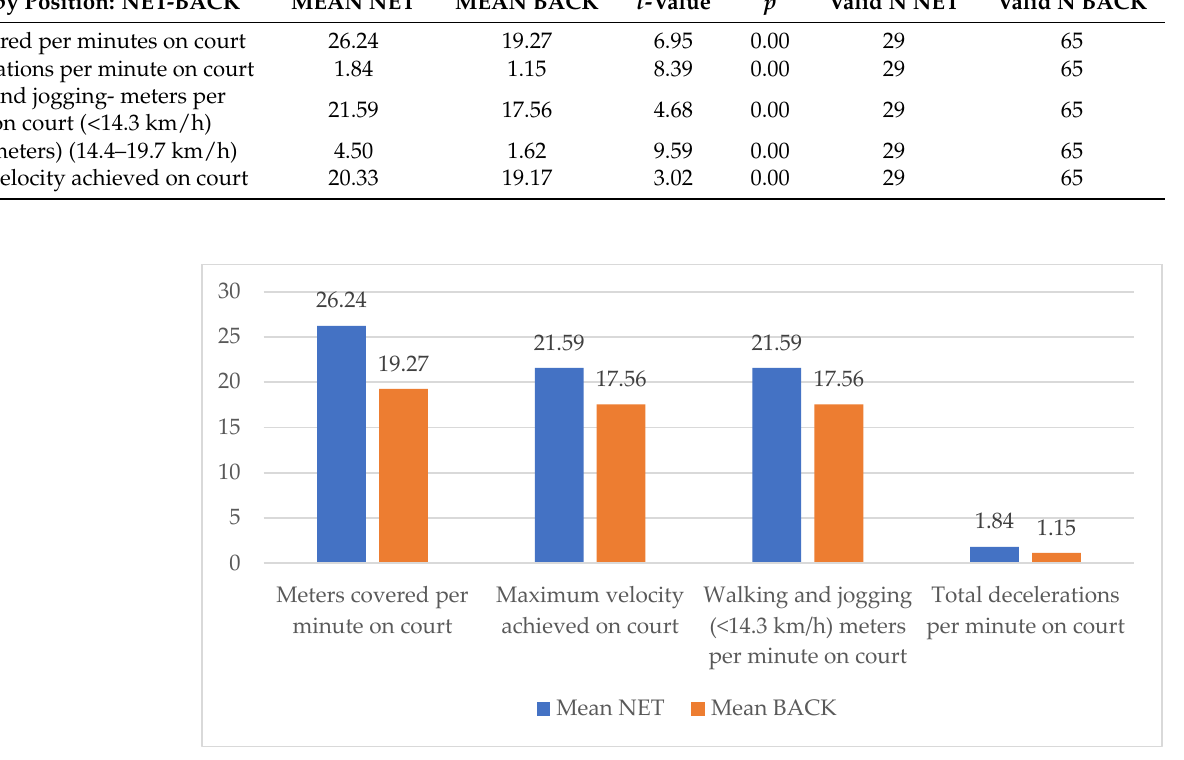
Figure 3. Visualization of differences between groups of ball kids at the net and at the back of the court.